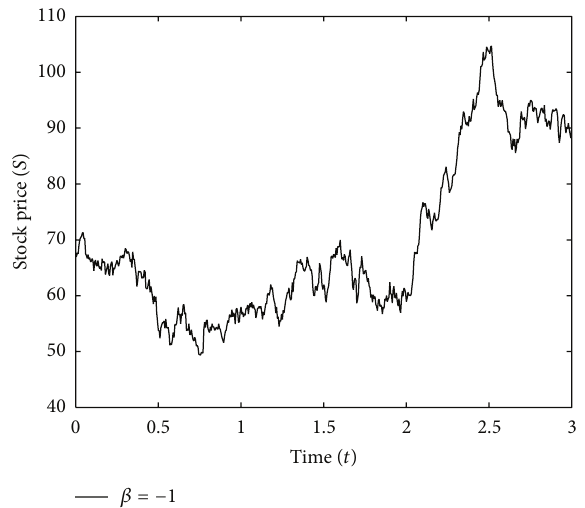
Figure 7: The evolution of stock price over time ( 𝛽 = −1